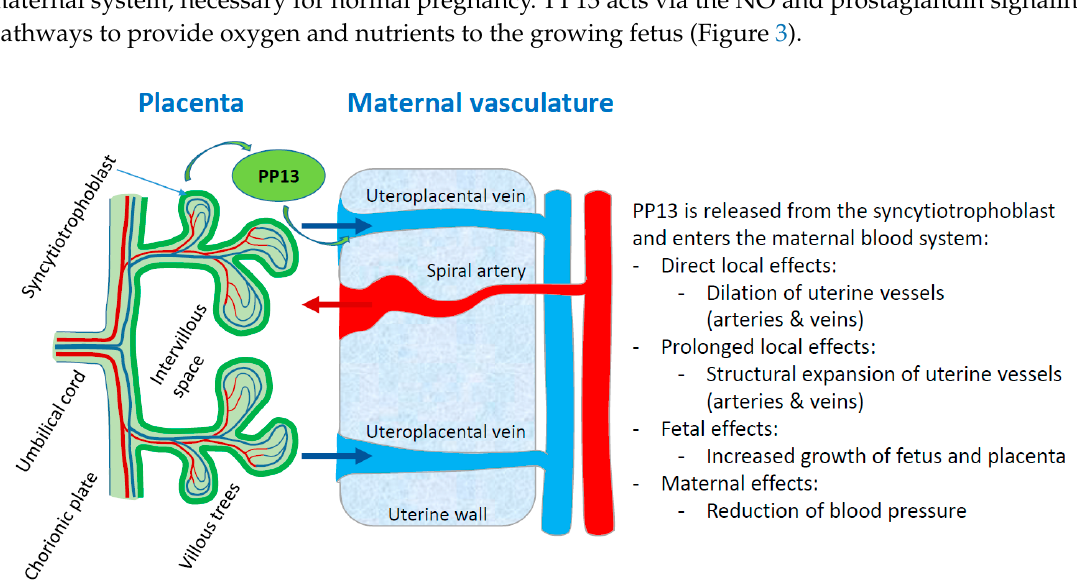
Figure 4. The effect of PP13 on the various layers of blood vessels. PP13 acts on the endothelial layer of the blood vessels and causes vasodilation by muscle relaxation through the signaling pathways of